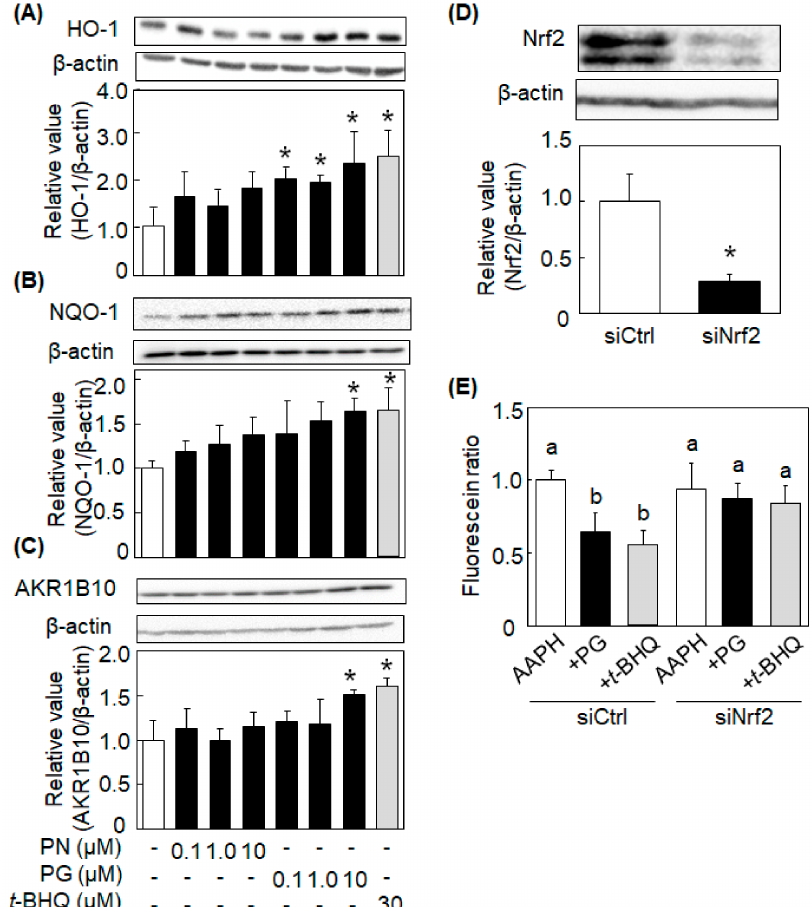
Figure 3. Induction of antioxidant enzymes by PG in HepG2 cells. HepG2 cells were treated with PN and PG and the protein expression level of antioxidant enzymes was detected by western blotting as described in Section 2.8. ( A ) Heme oxigenase-1 (HO-1), ( B ) NAD(P)H:Quinone oxidoreductase 1 (NQO1) and ( C ) Aldo-keto reductase family 1 member B10 (AKR1B10). Upper panels show typical blot data, while bottom ones are the intensity of specific bands after normalizing data by the β -actin level. Values are the mean ± SE ( n = 3), * p < 0.05 vs. control by Dunnett’s multiple comparison test. ( D ) HepG2 cells were transfected with siRNA and down-expression of nuclear factor-erythroid-2- related factor 2 (Nrf2) was confirmed by western blotting. Values are the mean ± SE ( n = 3), * p < 0.05 vs. control by Student’s t -test. ( E ) HepG2 cells were transfected with siNrf2, and AAPH-induced ROS scavenging activity was measured by DCFH-DA assay. Data are represented as the fluorescence ratio of AAPH alone to the compound-treatment. Values are the mean ± SE ( n = 5). Statistical significance is indicated by different letters ( p < 0.05) by Tukey’s multiple-range